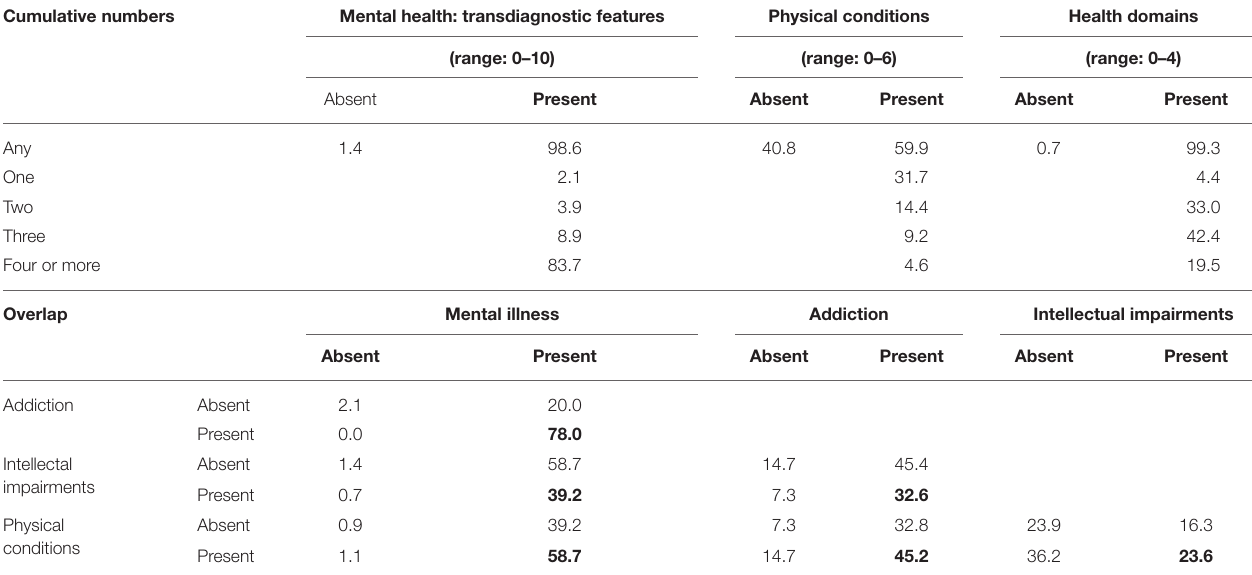
TABLE 4 | Cumulative numbers and overlap of concurrent health problems (in